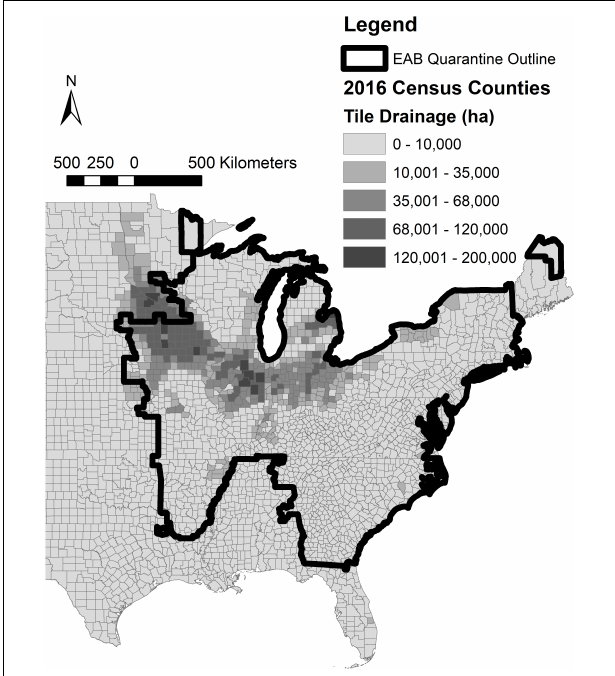
FIGURE 1 | Current Emerald Ash Borer federal quarantine boundary overlaid with the prevalence of subsurface drainage in the United States